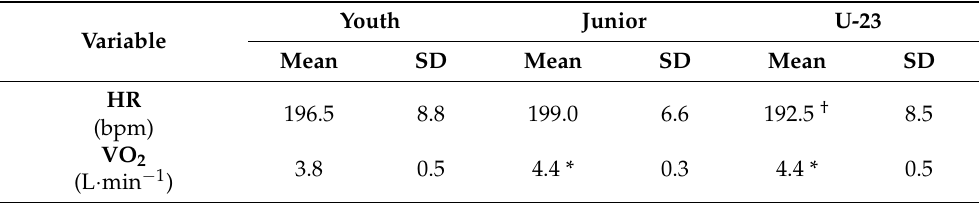
Table 3. Maximal values in the VO 2 max